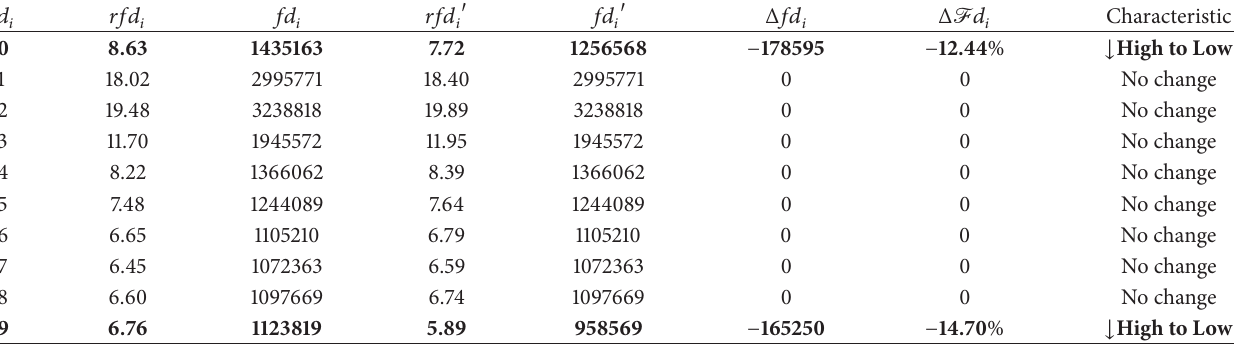
Table 7: Characterization of malicious deletion attacks on digit frequency.